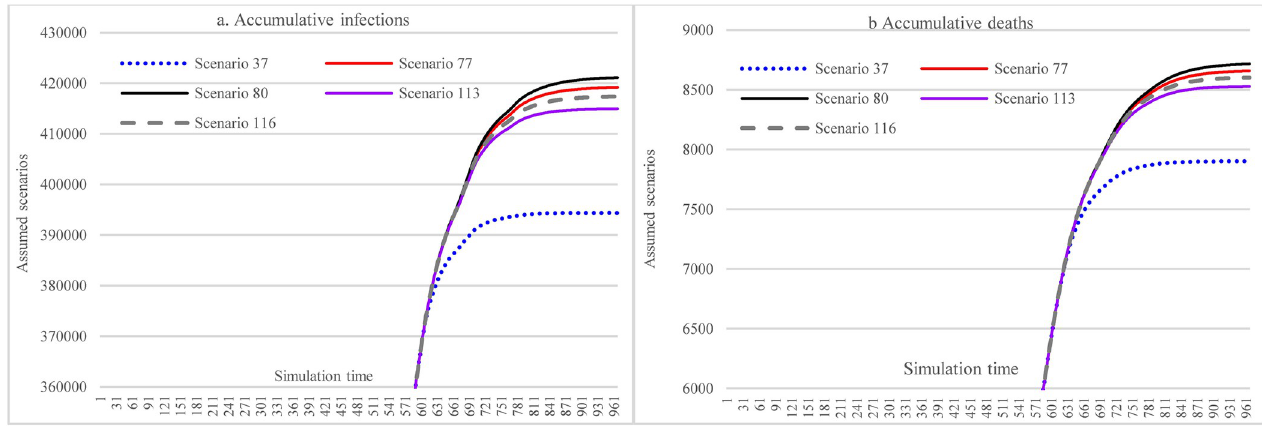
Fig 21. Implementing stringent SDMs versus less stringent SDMs and increased vaccination levels under the mask-wearing adherence level of 60%.